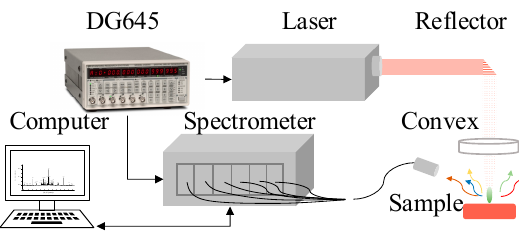
Figure 2. Schematic diagram of the LIBS setup. The LIBS setup includes a laser, a spectrometer, a digital delay generator, a computer and an optics